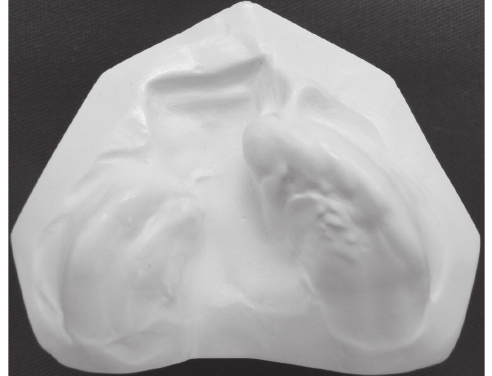
Figure 4- Study casts with standardized cuts proportional to the dental-alveolar areas